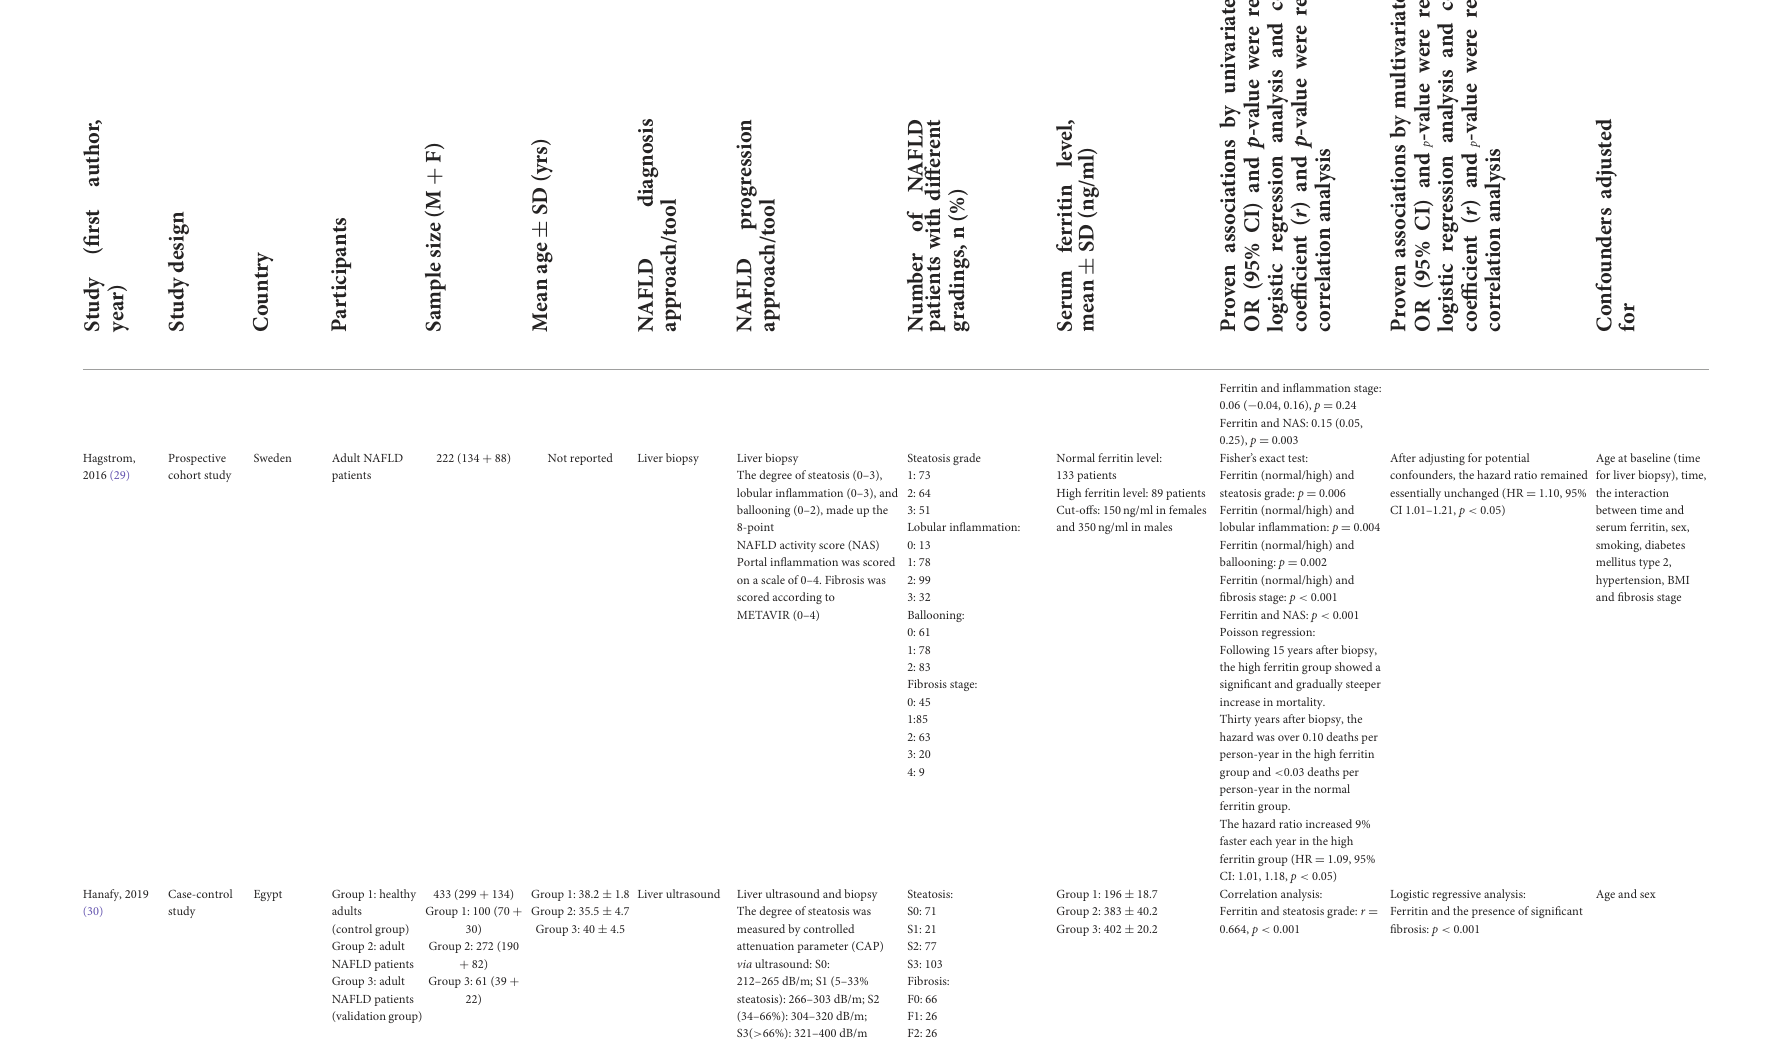
Afteradjustingforpotential confounders,thehazardratioremained essentiallyunchanged(HR = 1.10,95% CI1.01–1.21, p <